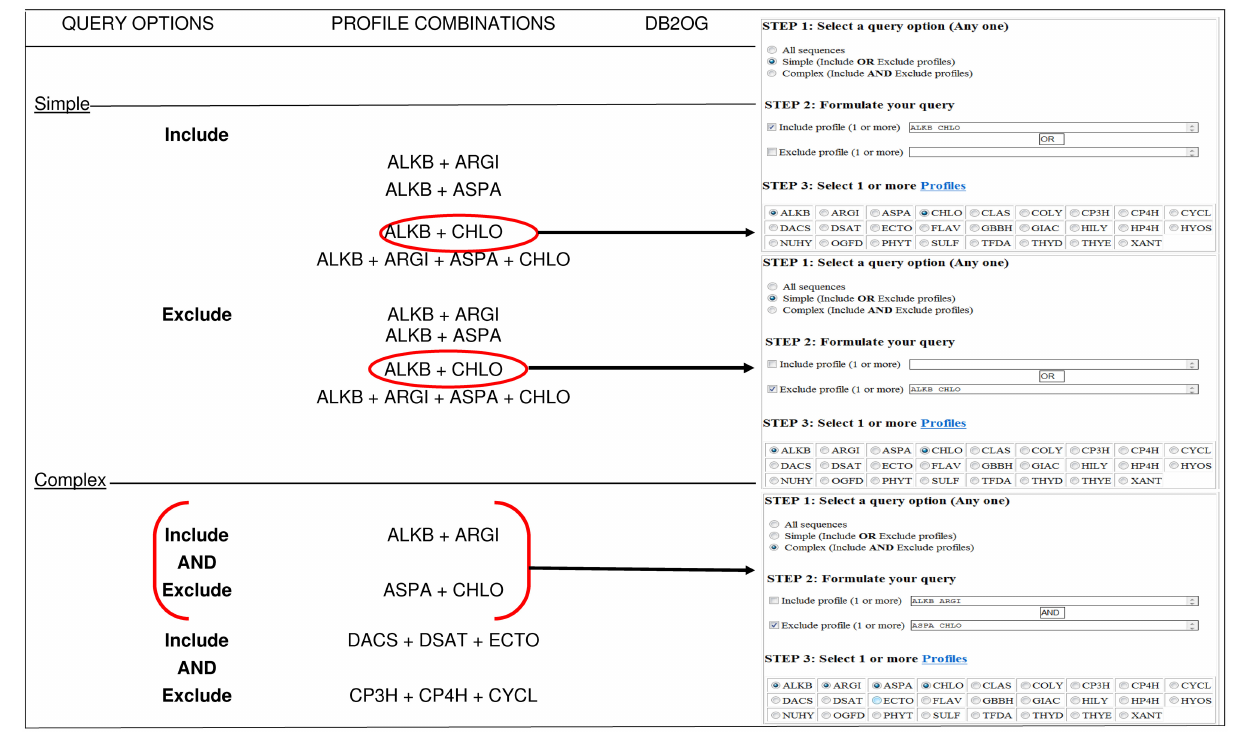
the profile of interest. Other sequences corresponding to variable subcellular locations may also be downloaded by clicking on the appropriate hyperlinks. NOTE: The browser window displaying the search results needs to be refreshed for each